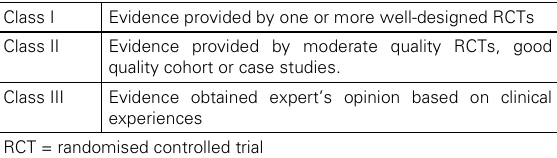
Table 1: Classification of evidence (adapted from Soleman et al. [4] and Lawrence et al. [20, 21]). Class I